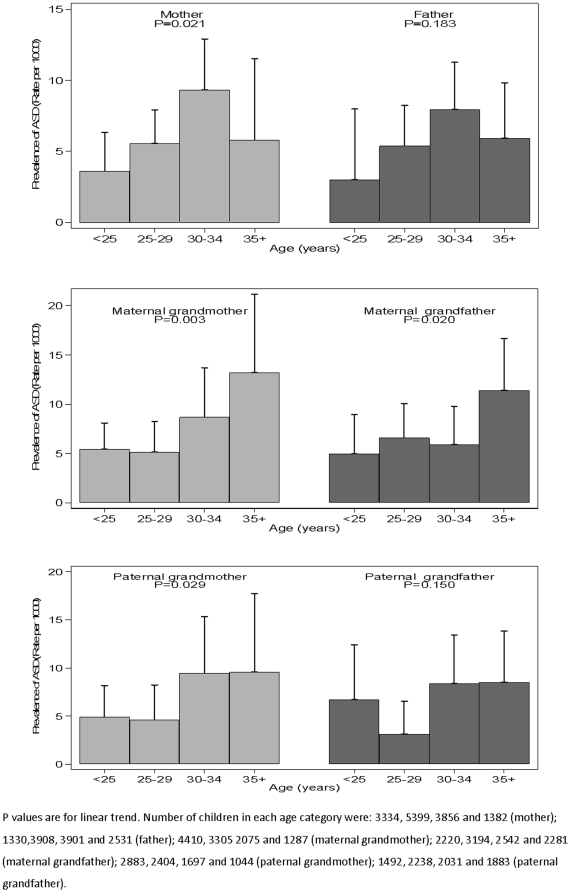
Rates per 1000 of a child having ASD are shown according to ages of parents at child's birth and of grandparents at parents' birth with 95% CIs.